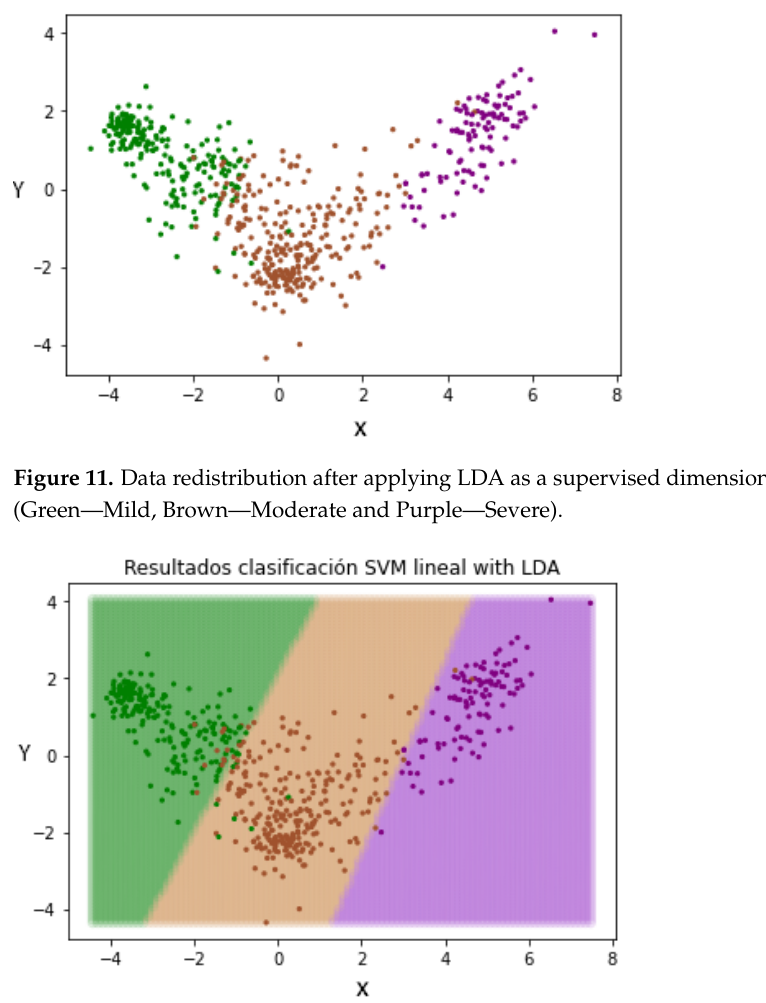
Figure 12. Data redistribution after applying LDA as a supervised dimensionality reduction method. (Green—Mild, Brown—Moderate and Purple—Severe).